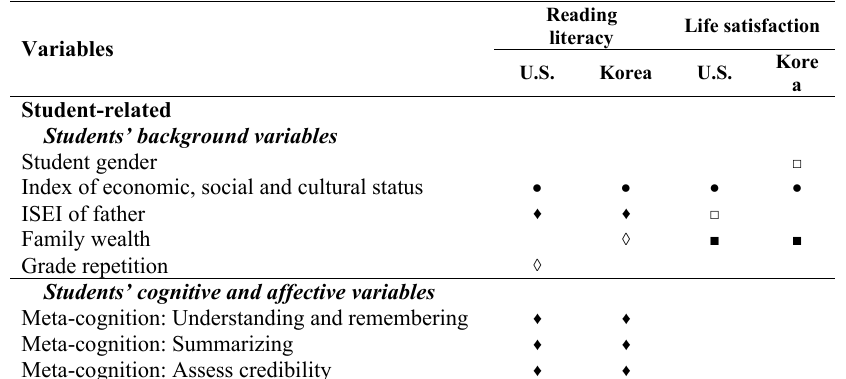
Table 1 Key variables selected from the random